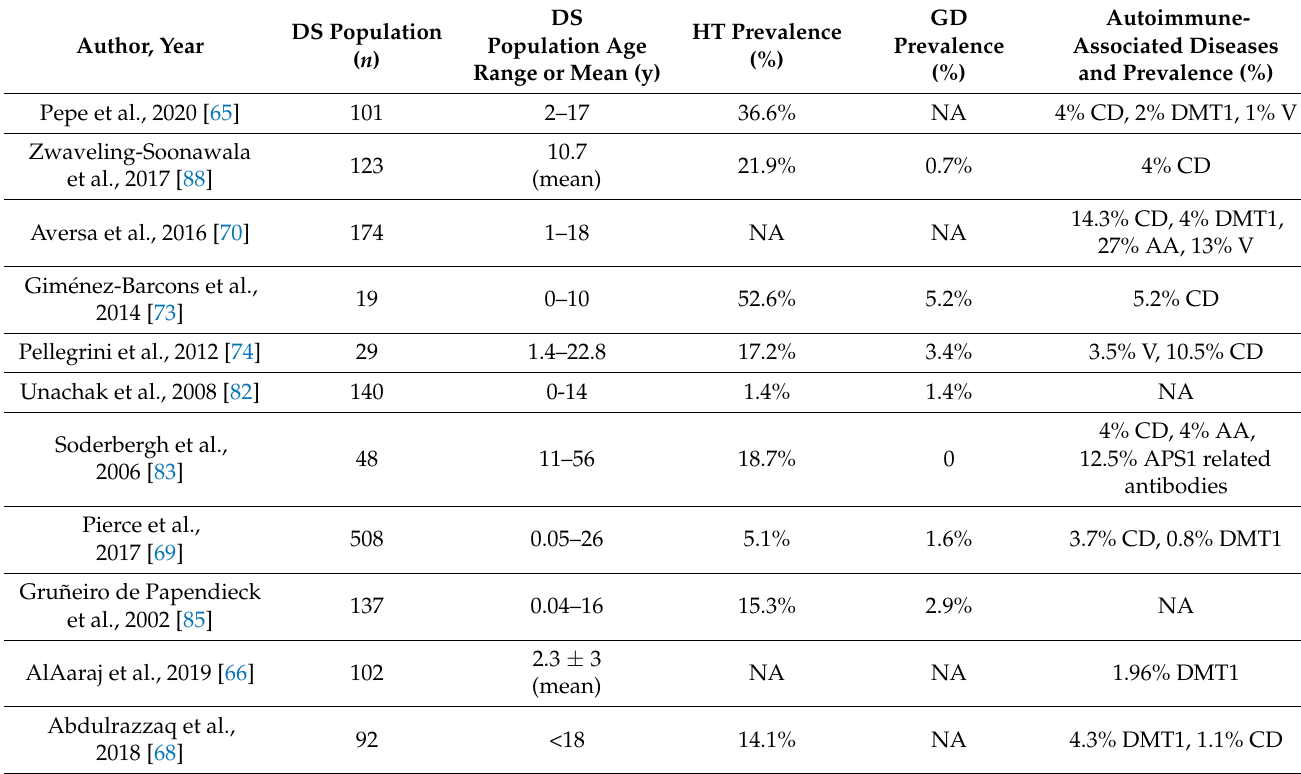
Table 3. Autoimmune thyroid disease (AITD) prevalence and association with other autoimmune diseases, among different studies, in Down syndrome